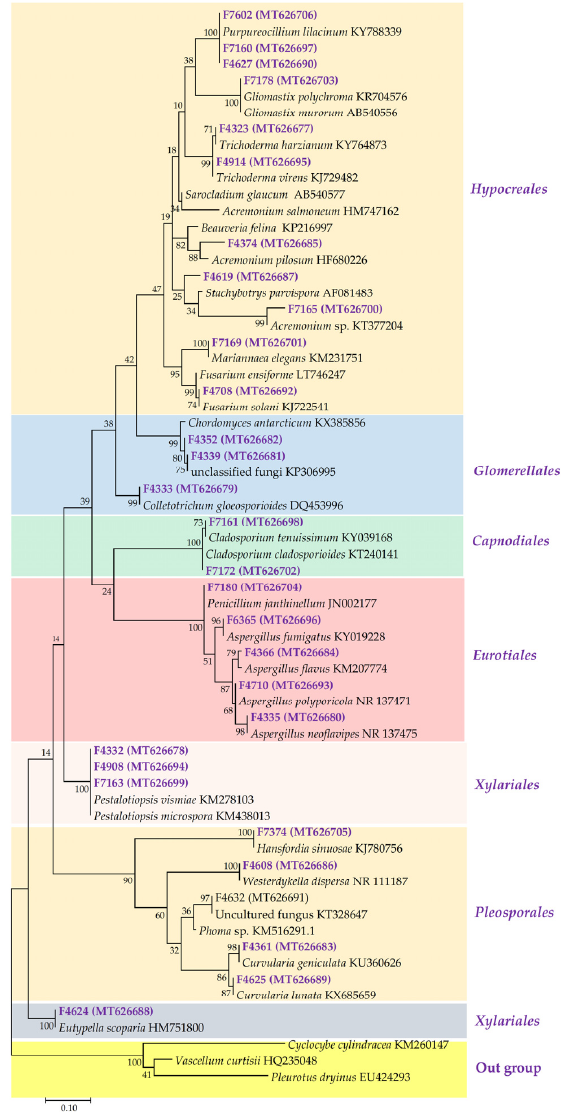
Figure 1. The phylogenetic tree of the 30 ascomycetes (shown in purple) constructed using ITS2 sequences. The tree topology is based on the neighbor-joining method. ITS2 sequences from three Basidiomycota species were used as outgroups. Reference sequences obtained from GenBank have their accession numbers indicated. Bootstrap values greater than 50% are shown at the nodes. The tree is drawn to scale; scale bar represents nucleotide substitutions per site. Evolutionary analyses were conducted in MEGA7. Accession numbers are shown in